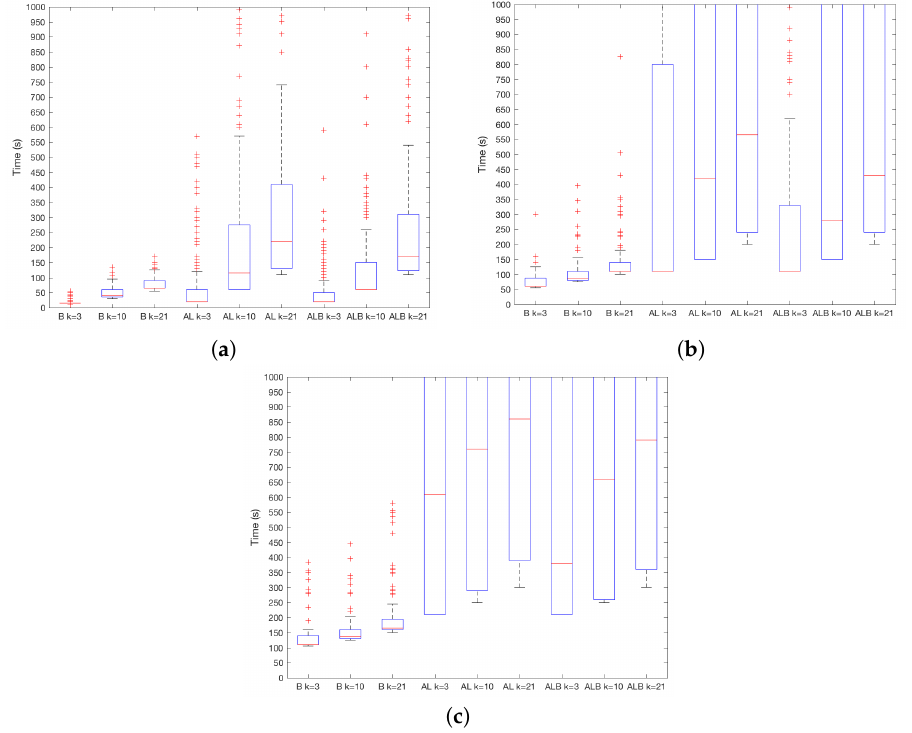
Figure 5. T SEC results depending on parameter k . ( a ) ST = 1; ( b ) ST = 10; ( c ) ST =